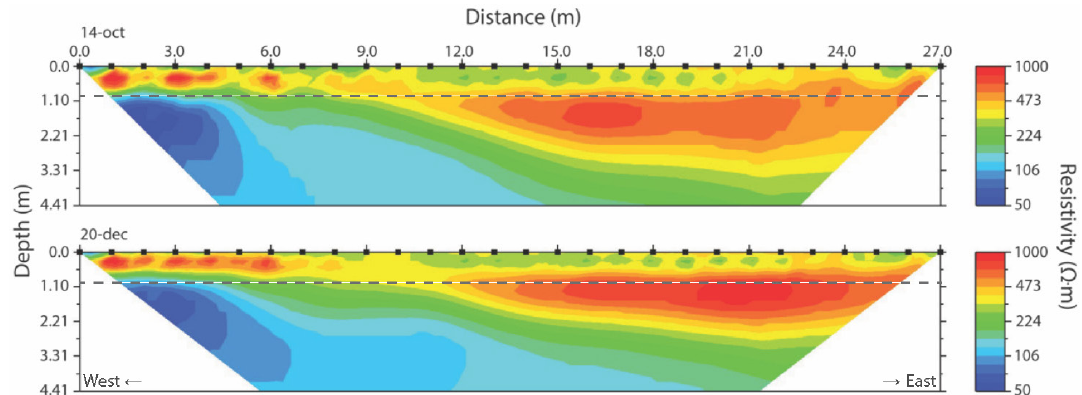
Figure 5. Resistivity profiles for the beginning (14 October) and the end (20 December) of the experiment along the 28 m transect. With inversion RMS-errors (%) of 1.20 and 1.13, respectively. The dashed line at 90 cm depth refers to the correlation analysis discussed further on.